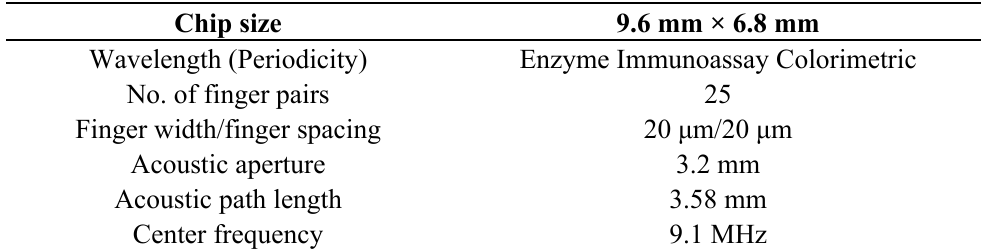
Table 2. Specifications of the FPW-based allergy biosensor.